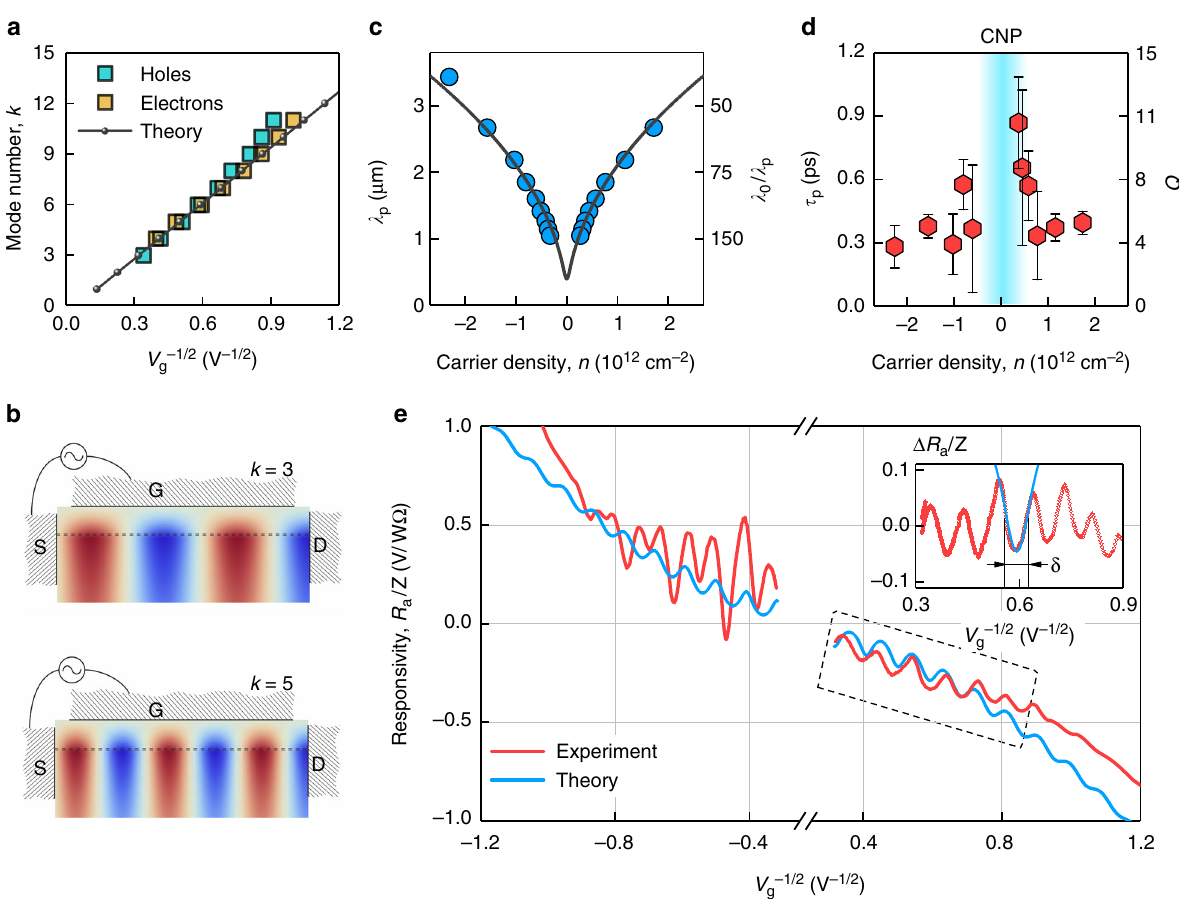
(symbols). Solid line: theoretical dependence for L = 6 μ m, Fig. 3 Plasmon resonances in encapsulated graphene FET. a Mode number k as a function of V (cid:2) 1 = 2 g m = 0.036 m f = 2THz. The fi rst mode supported by our Fabry-Pérot plasmonic cavity corresponds to k = 3; the fundamental mode with k = 0 is e , and min beyond the accessible gate voltages. b Examples of high-frequency potential distribution in the plasmon mode (real part) under resonant conditions for given k . Brown and blue colors represent positive and negative values of electrical potential, respectively. S, G, and D stand for source, gate, and drain terminals, respectively. c Experimental (symbols) and calculated (solid line) plasmon wavelengths λ p as a function of carrier density, as obtained from a . The corresponding value of the inverse compression ratio, λ 0 / λ p , for f = 2THz is given on the right axis. d Plasmon lifetime τ p and quality factor Q as obtained from the width of the resonances shown in e . Error bars stem from the fi tting procedure. e Experimental and calculated responsivities as functions of V (cid:2) 1 = 2 , g = P relating the incident power to the resulting gate-to-channel voltage V normalized to the effective antenna impedance Z ¼ V 2 a . The theoretical Dyakonov- a Shur dependence (Supplementary Note 9) was obtained by using characteristic τ p = 0.6ps from d . Inset: normalized responsivity R a / Z after the subtraction of a smooth non-oscillating background. The solid blue line is the best Lorentzian fi t to the data, with δ = 0.1 V − 1/2 , which translates to τ p =